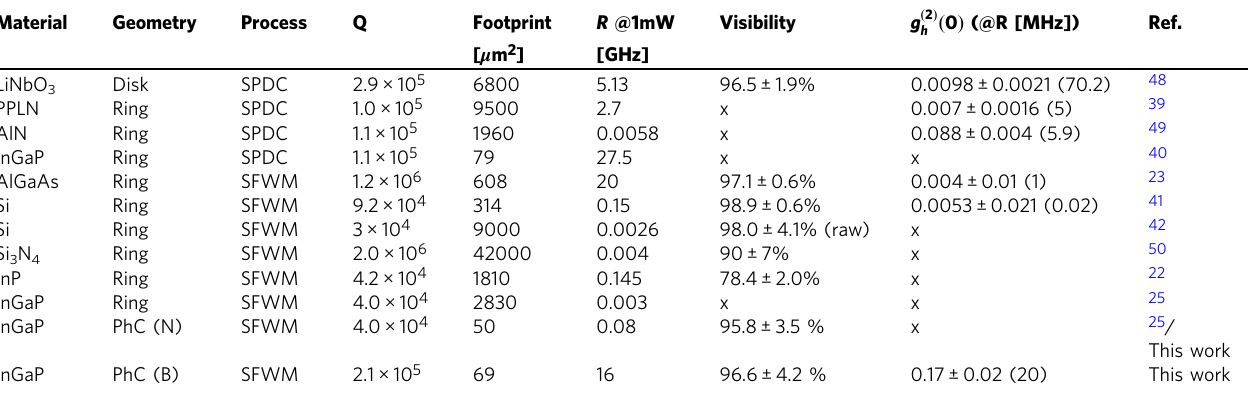
Table 2 Photon pair sources via resonant parametric processes (SPDC and SFWM) in microresonators. Material